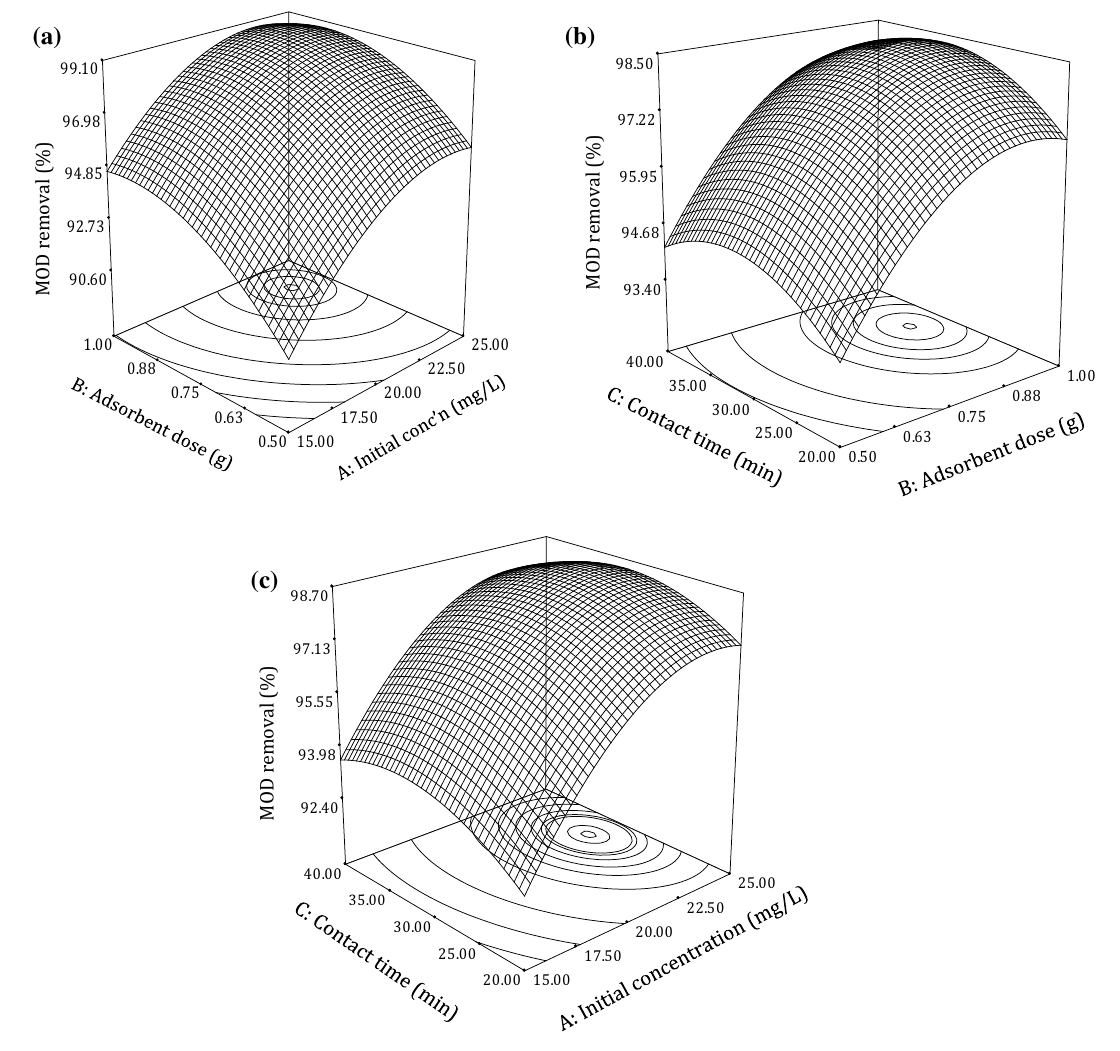
Fig. 4 3D response surface showing interactive effects of chosen variables in MOD